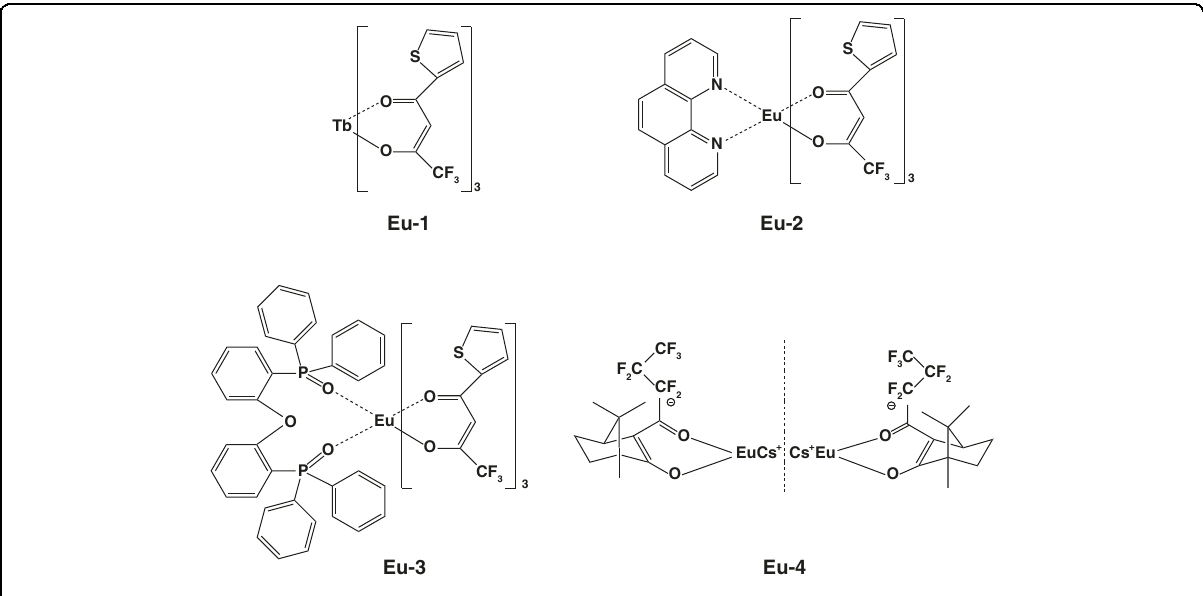
Fig. 6 The complexes structures of Eu-1-